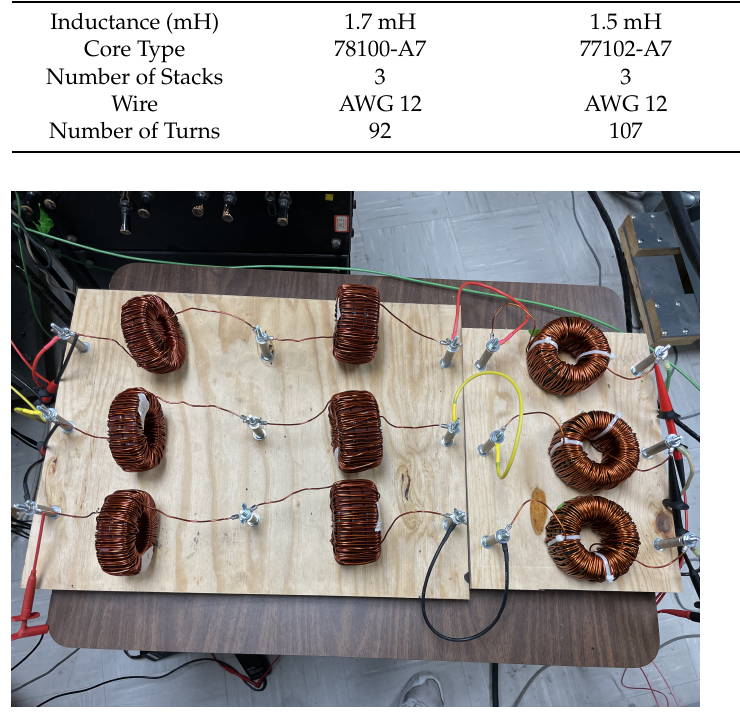
Figure 13. The balanced grid inductance with 4.2 mH.